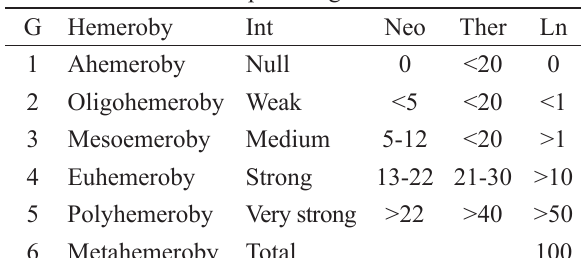
Table 9. Hemeroby grades in the plant communities (see text). Abbreviations are: G: Grade; Int: Intervention; Neo: Neophyten; Ther: Therophyten; Ln: Loos of native. Data on